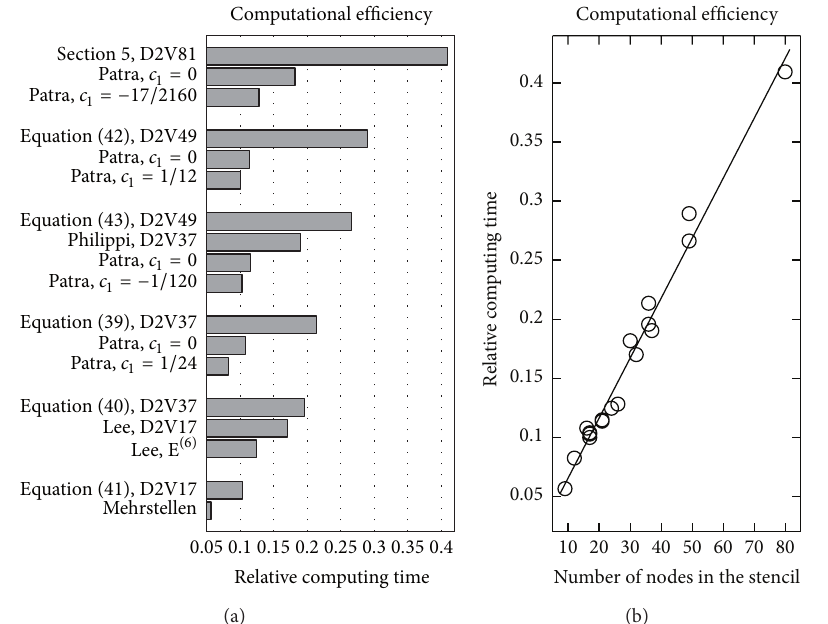
Figure 2: The relative computational times of Table 3 in a graphical format. On the right, the relative times are plotted as functions of the number of nodes in the finite-difference stencils; the line indicates a linear fit. References for the above compared approximations are as follows: Lee et al. [11, 12], Patra and Karttunen [2], and Philippi et al.